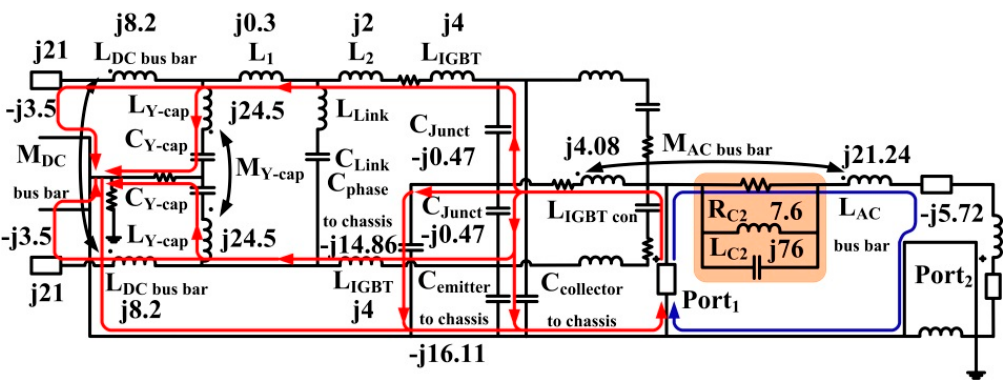
Figure 16. Current ‐ following path after adding a CM ferrite choke through the AC bus bar. Figure 16. Current-following path after adding a CM ferrite choke through the AC bus bar. Energies 2016 , 9 , 419